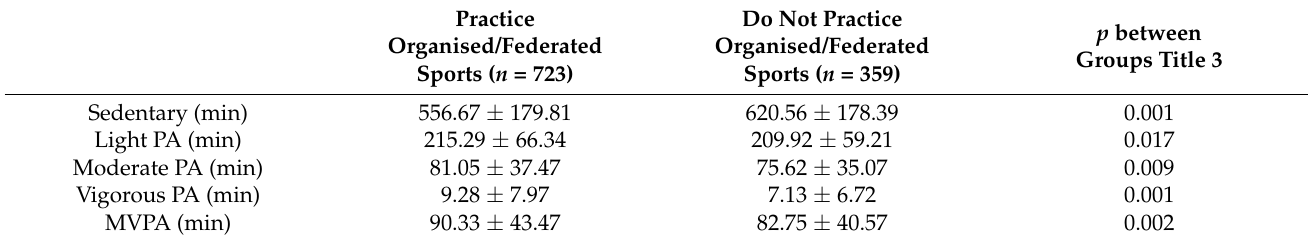
Table 3. Results of the daily physical activity (PA) levels and sedentary